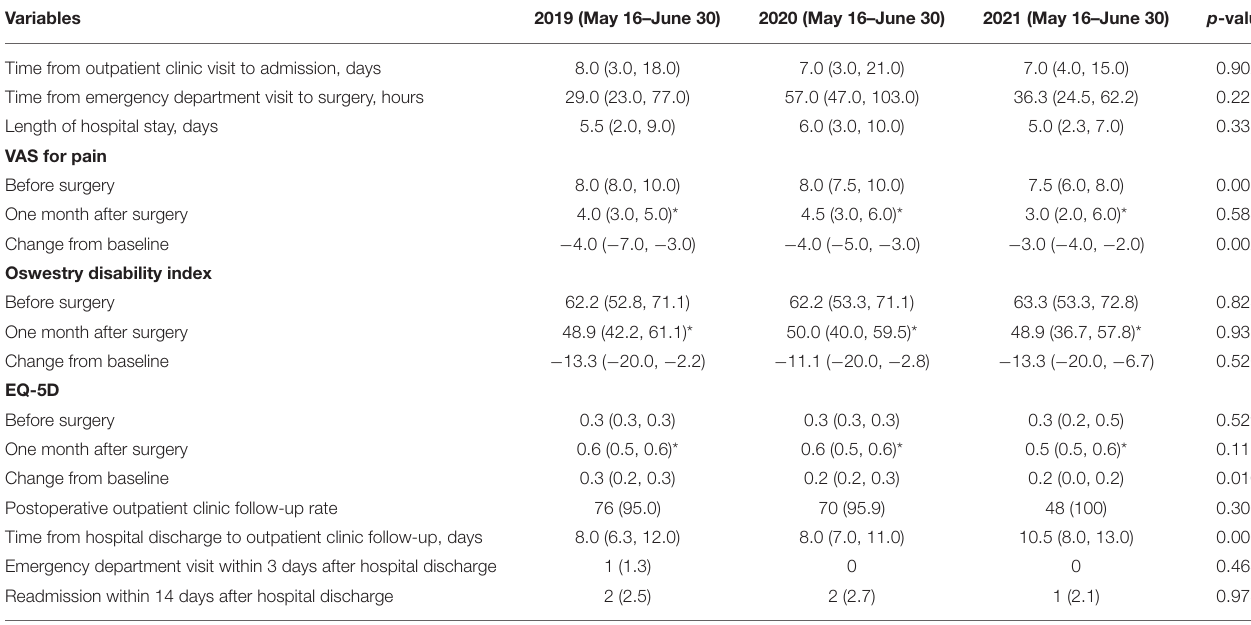
TABLE 3 | Parameters related to quality of care according to the year of surgery.